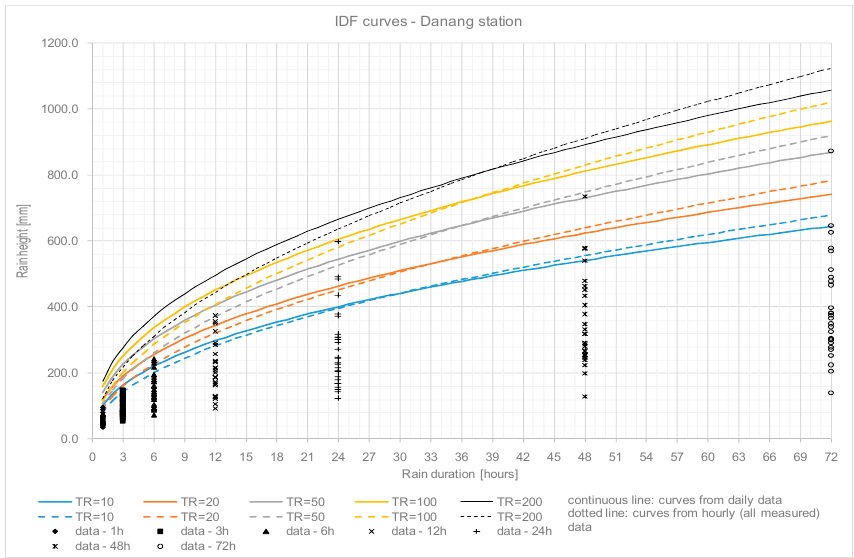
continuous line: curves from daily data dotted line: curves from hourly (all measured) data